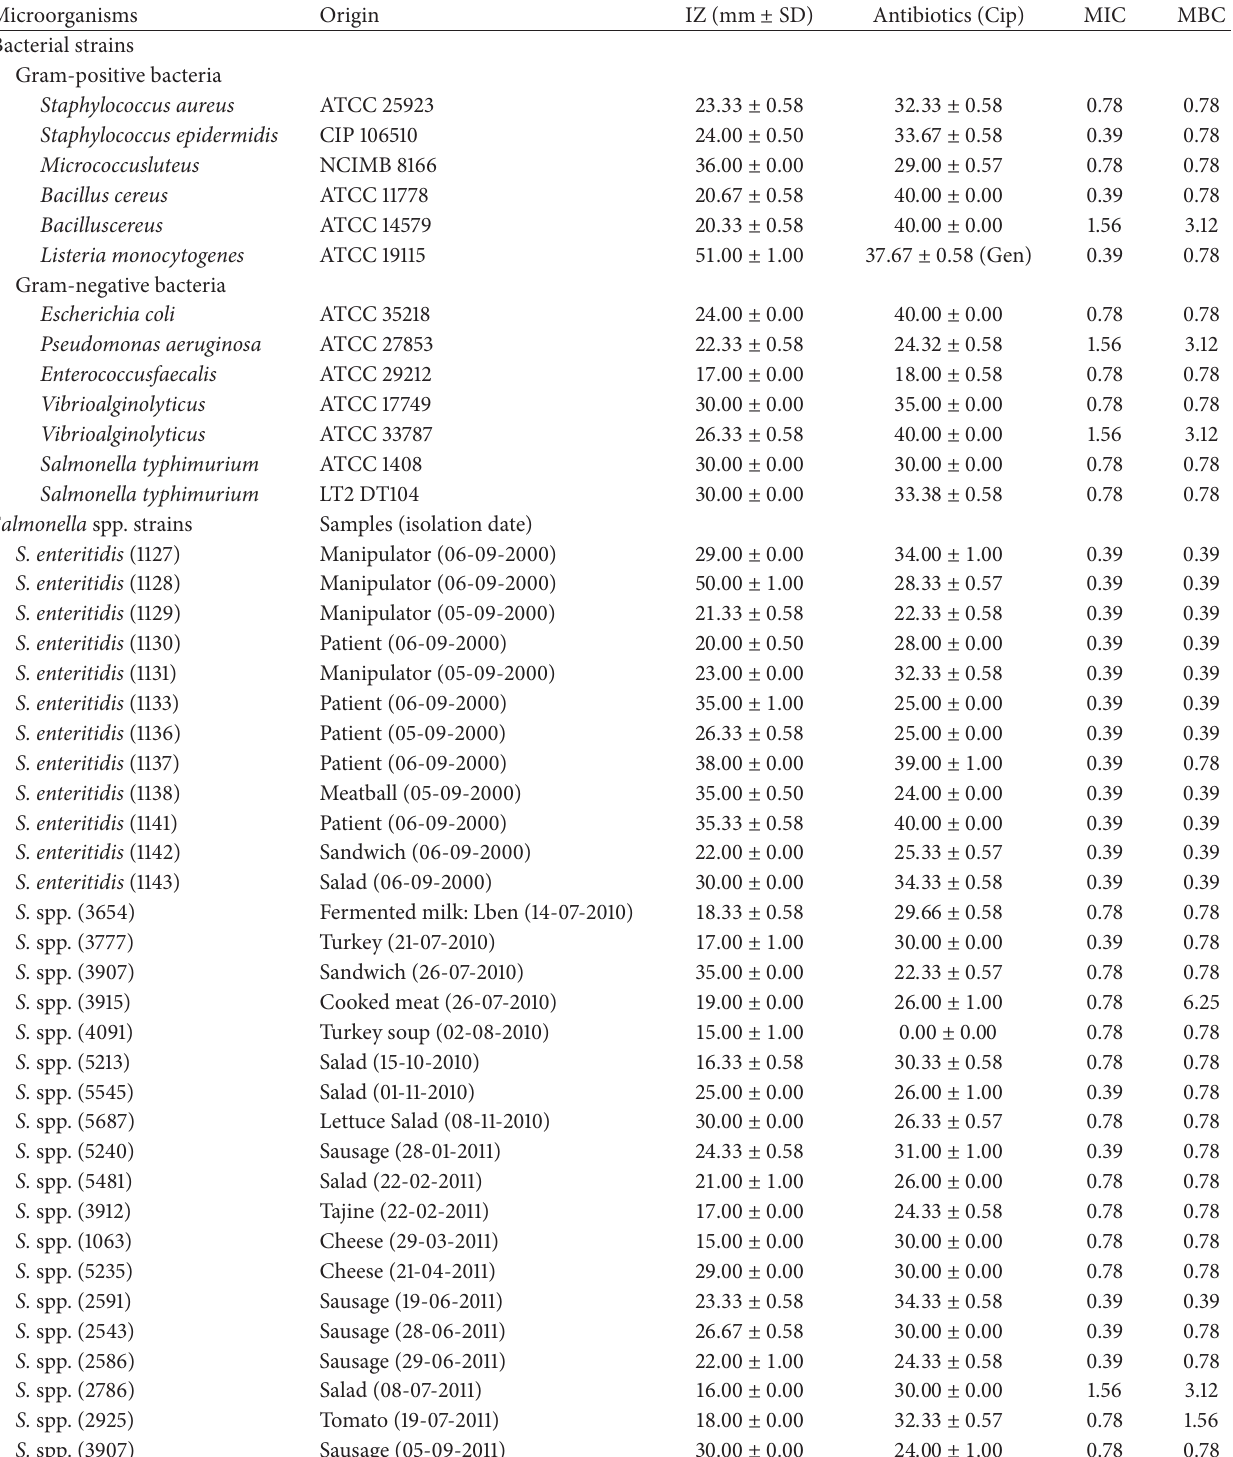
Table 2: Antibacterial activity of S. montana L. essential oil against human pathogenic bacteria using agar disc diffusion method and determination of MIC (mg/mL) and MBC (mg/mL)